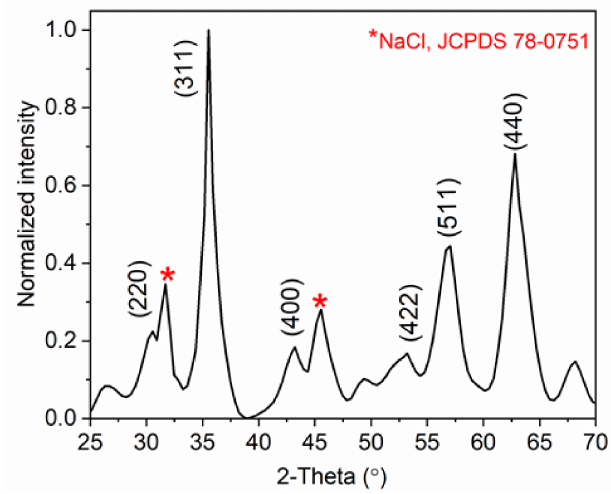
Figure 3. XRD diffractogram for MNPs@SiO 2 @Lys.